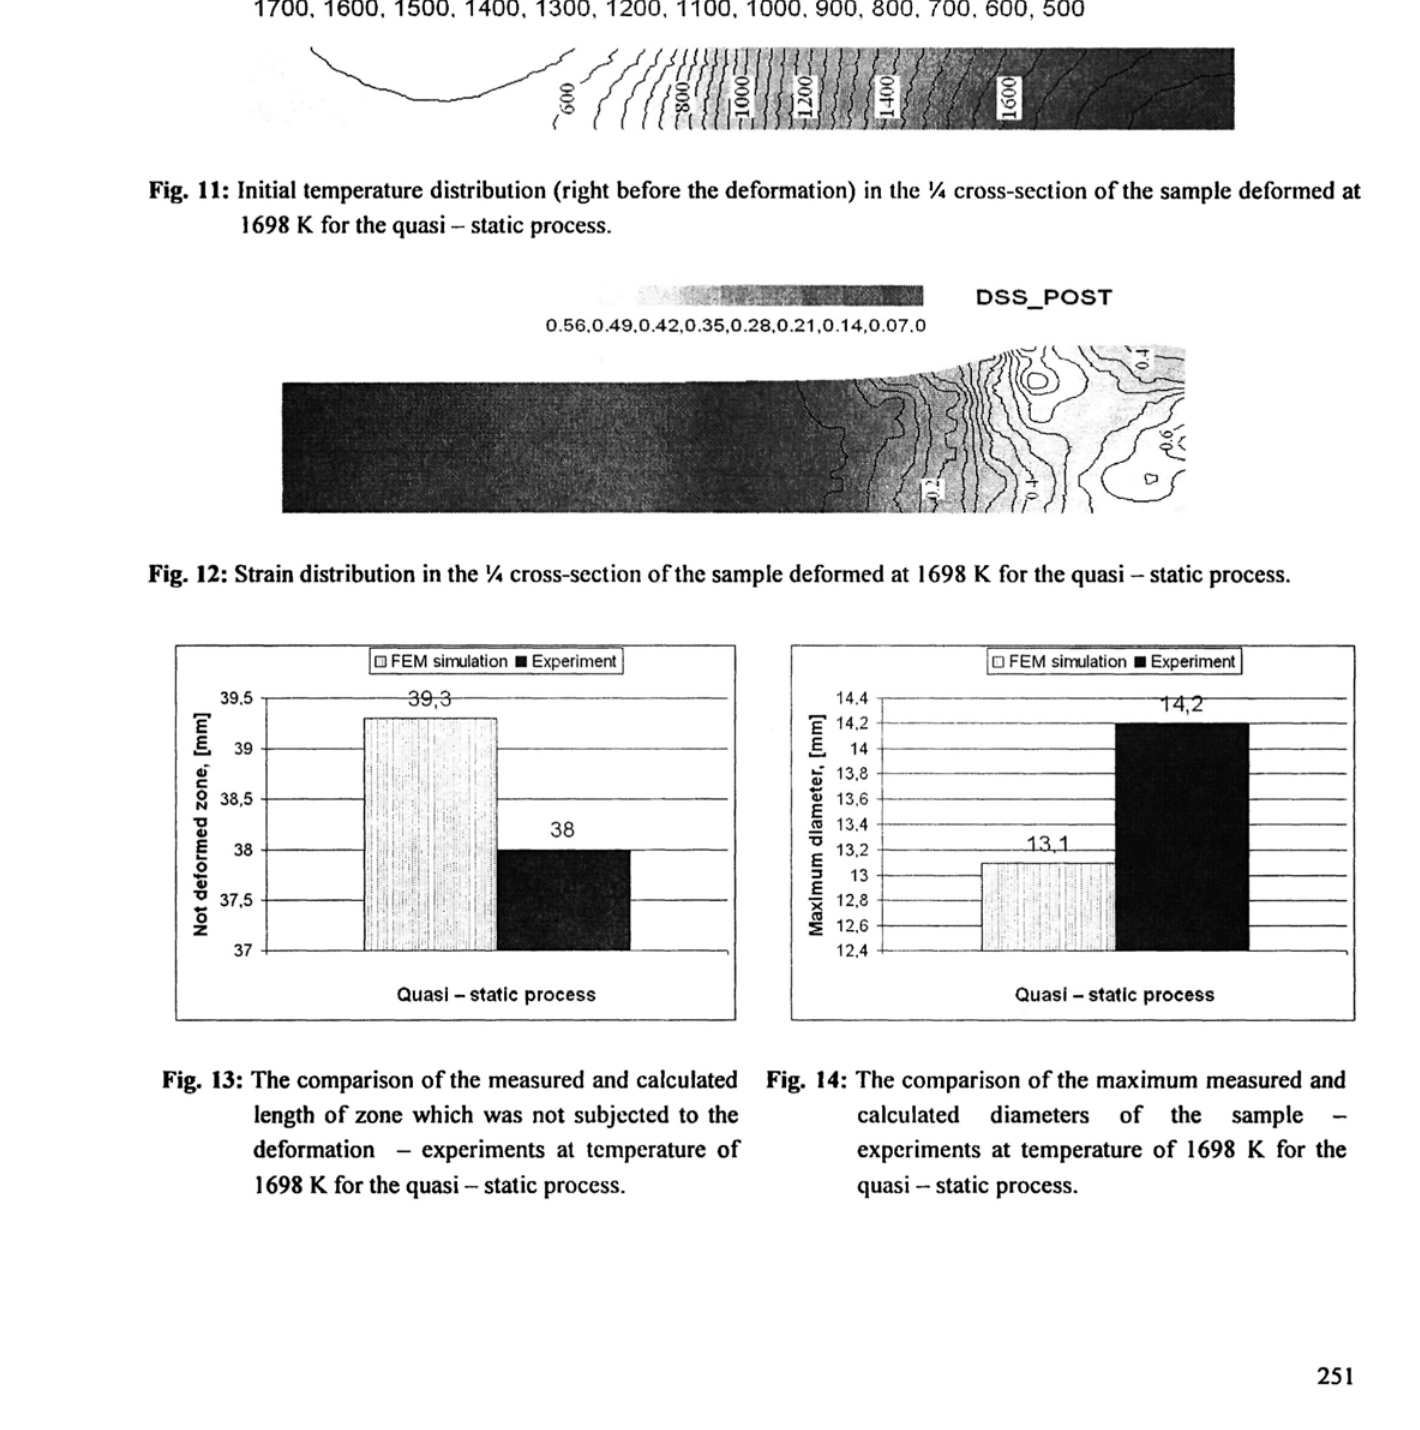
Fig. 10: Temperature distribution after 5 seconds of heating.